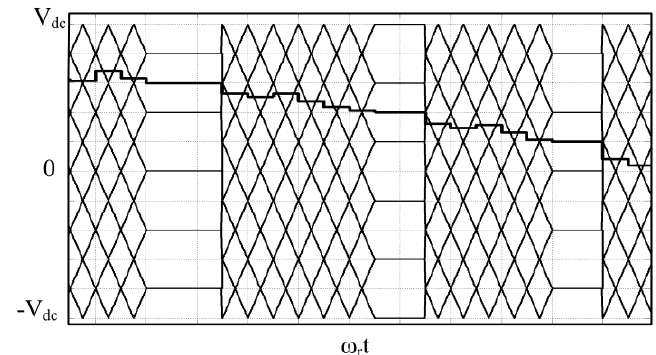
Figure 10. Carriers and reference under the discontinuous modulation.